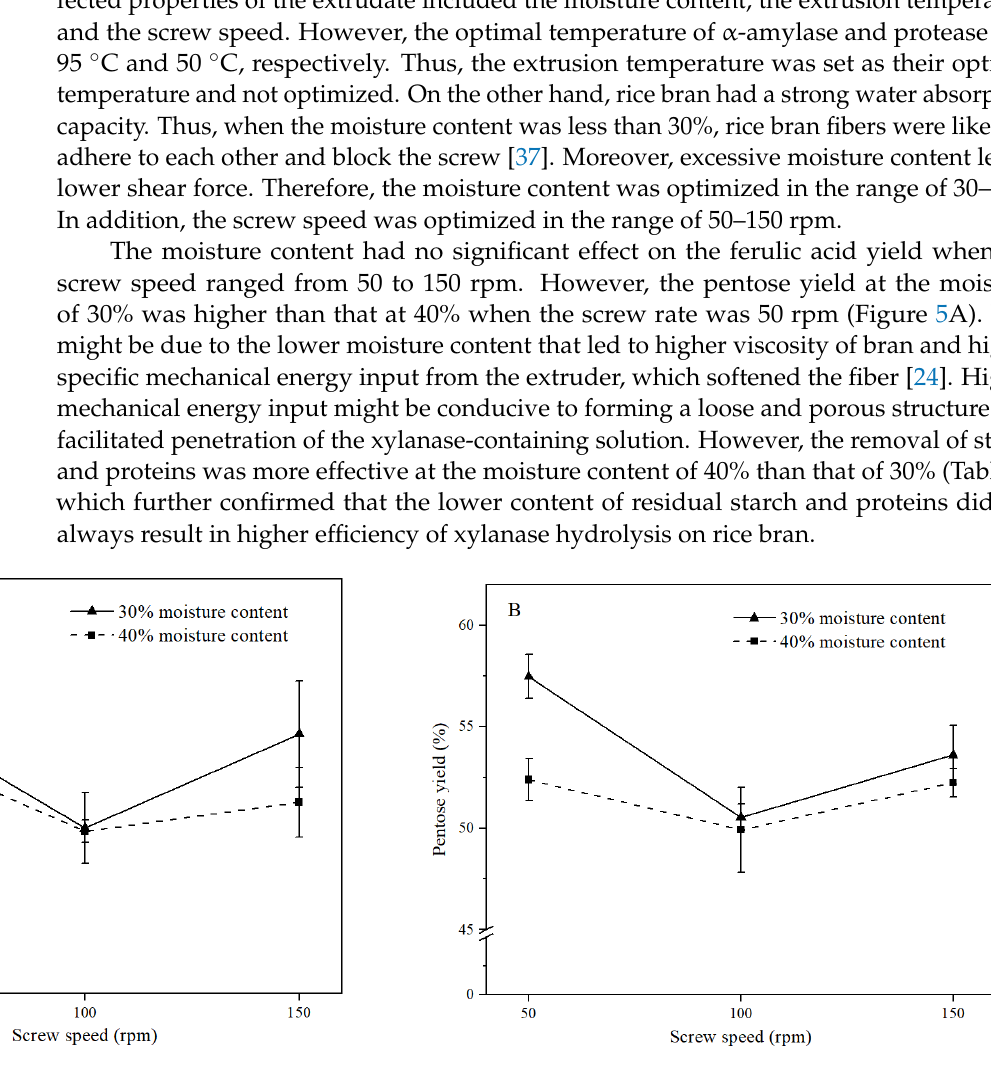
Figure 5. Effects of the moisture content and the screw speed on the ferulic acid yield ( A ) and pentose yield ( B ). Table 3. Composition of enzymatic extruded bran fiber concentrates (%, dry